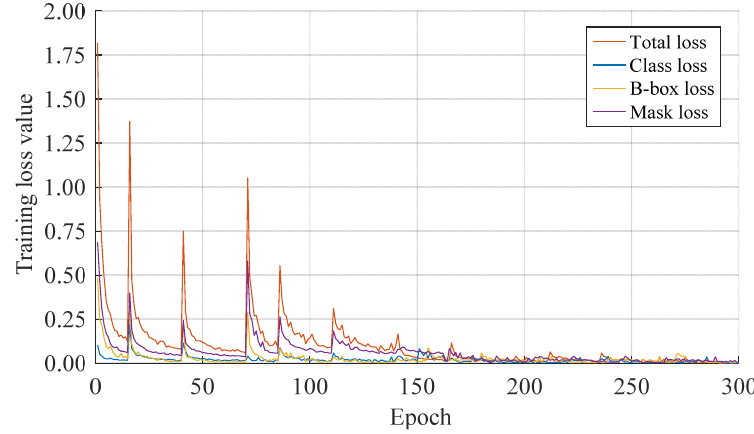
Figure 10. The training loss convergence of the model and its branches.